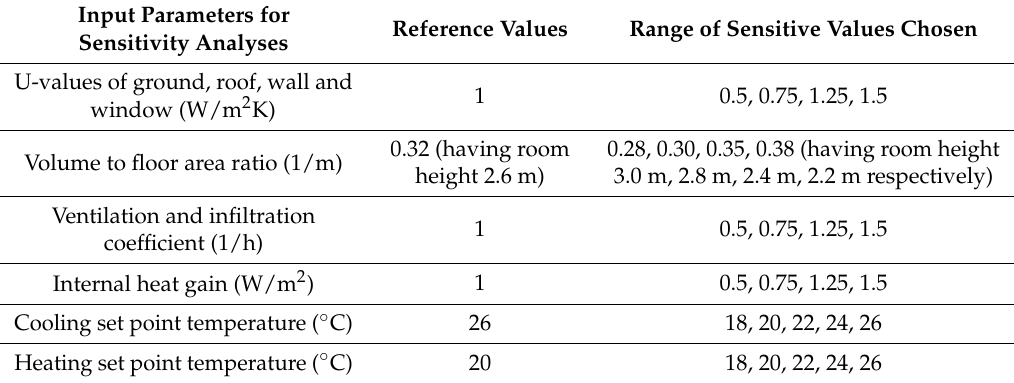
Table 3. Range of sensitivities chosen for the input parameters.